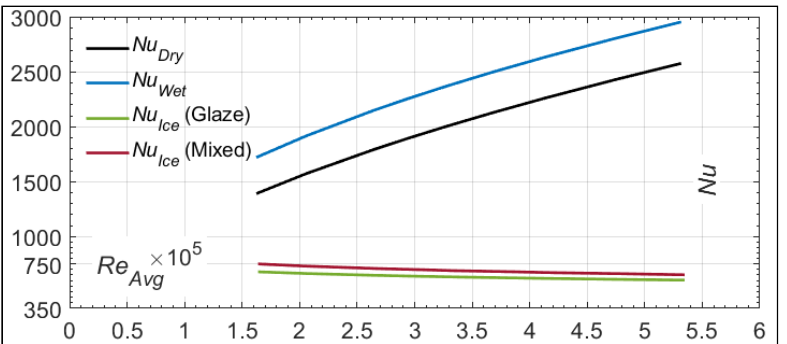
Figure 24. A Comparison of the Correlation Predictions versus Re Avg for the Nu Dry and the Nu Wet as well as both types of Nu Ice.